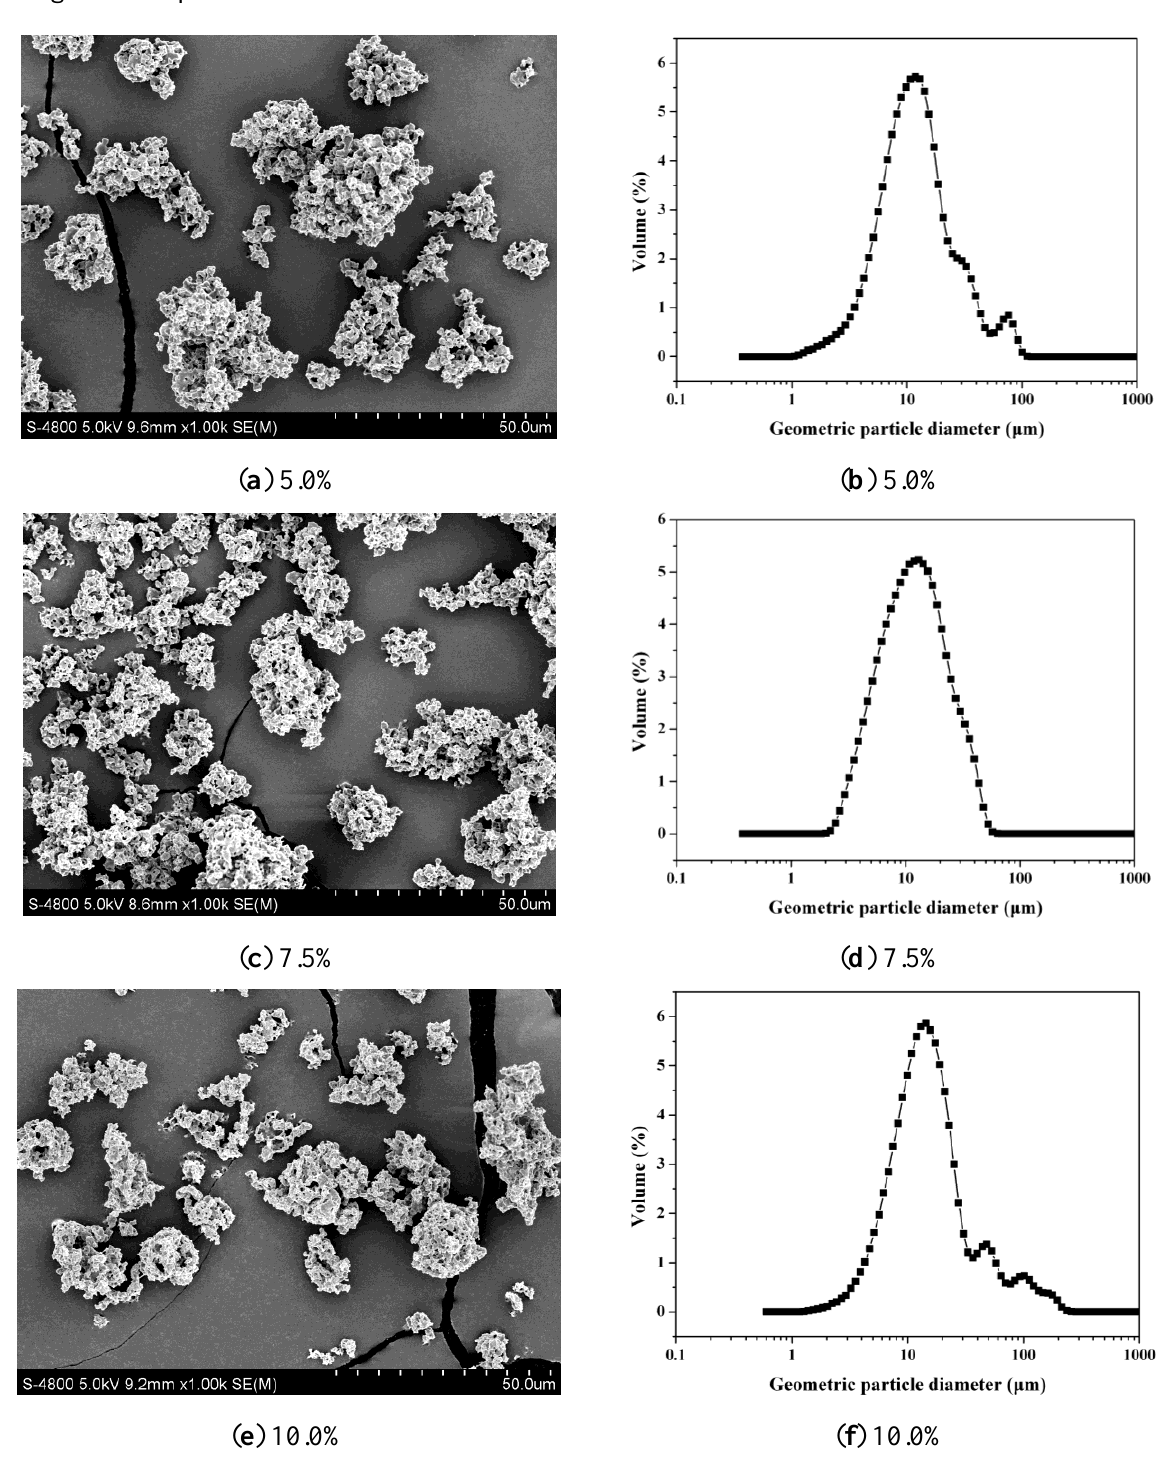
Table 1. Results of aerodynamic properties of LSZ-PLLA